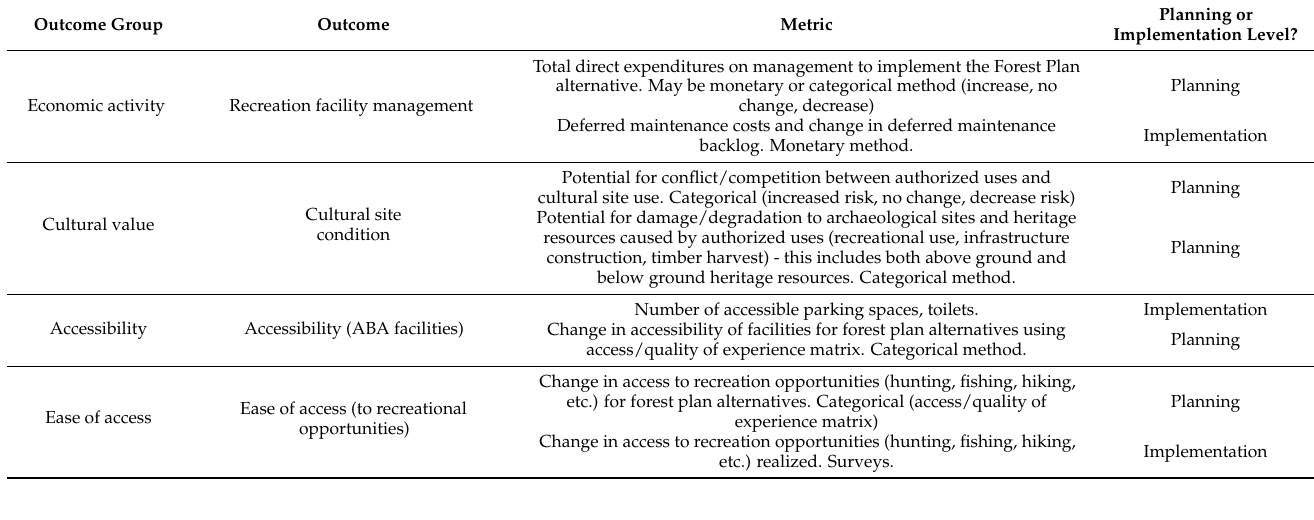
Table 2. Example ecosystem services metrics related to recreation for the Ashley National Forest Plan. ABA is an abbreviation for Architectural Barriers Act, which is a U.S. law requiring federal facilities be accessible to all people (e.g., wheelchair and stroller accessible).